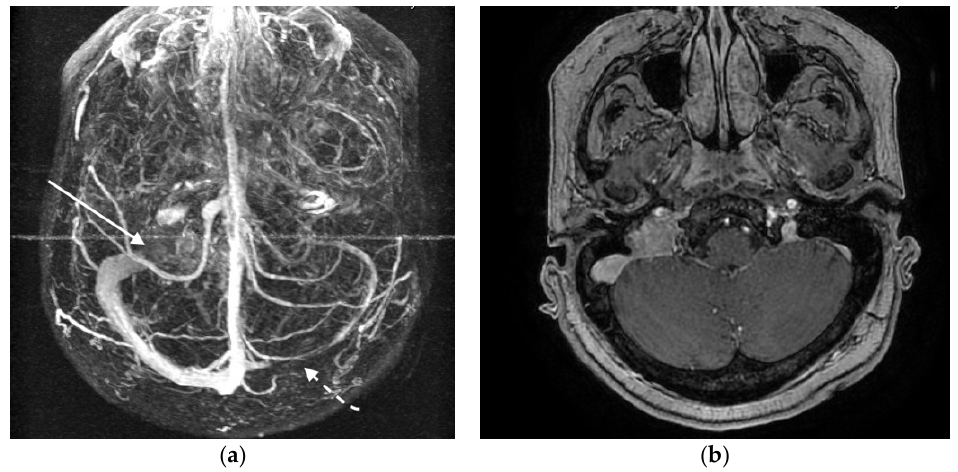
Figure 4. ( a , b ) Contrast ‐ enhanced MRI and magnetic resonance venography demonstrating hypoplasia of the right transverse sinus (dotted arrow) and tumor invasion of the left jugular bulb (continuous arrow).